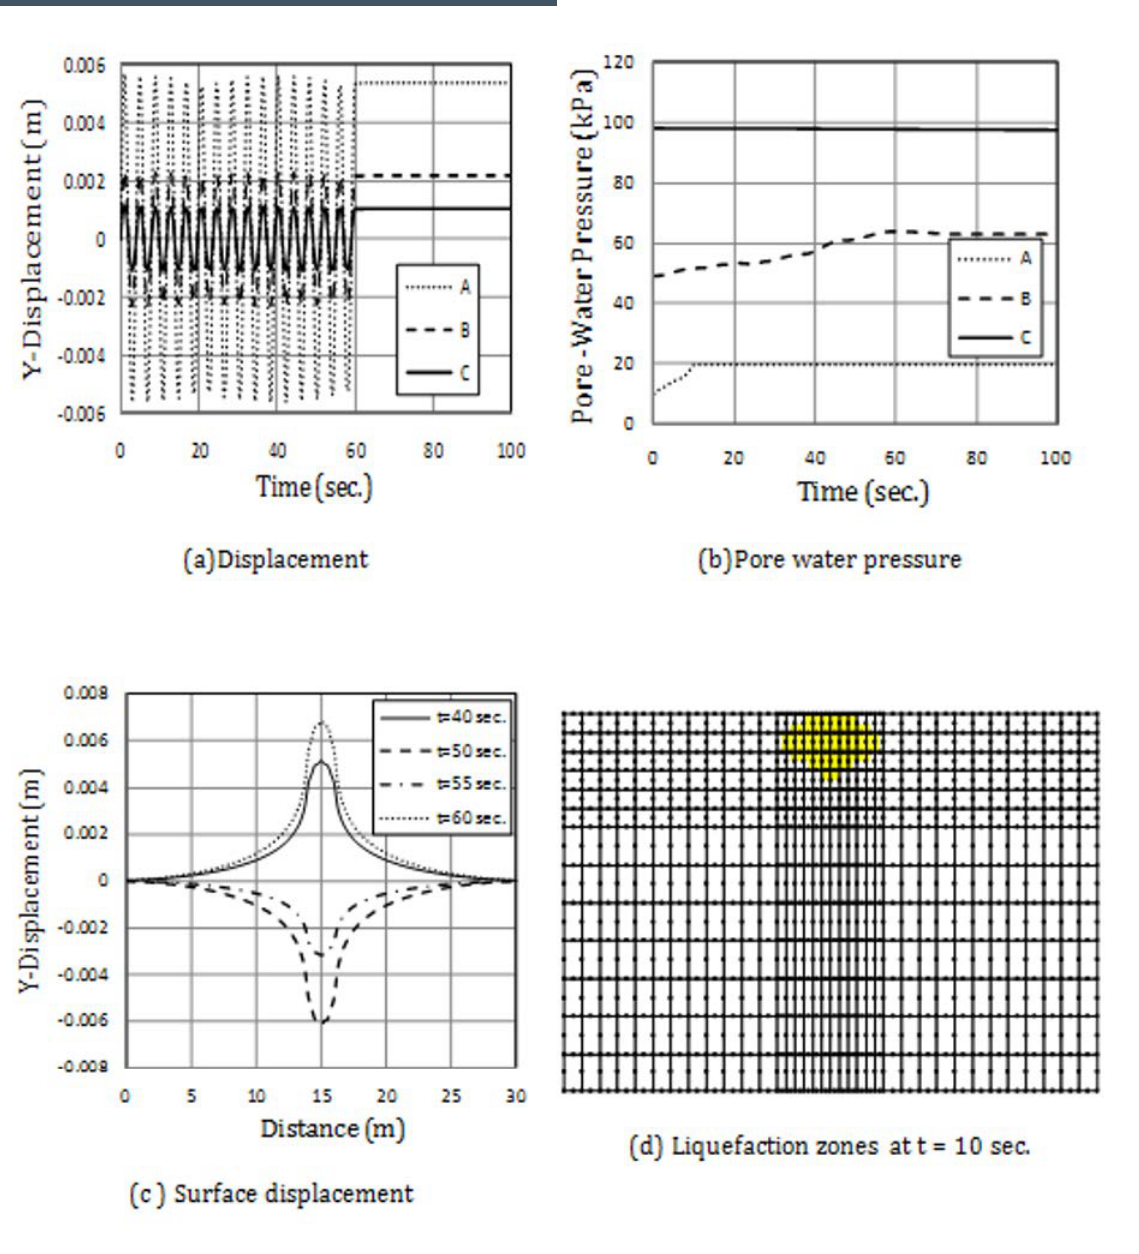
Figure 10. Dynamic response of the foundation to harmonic load, a